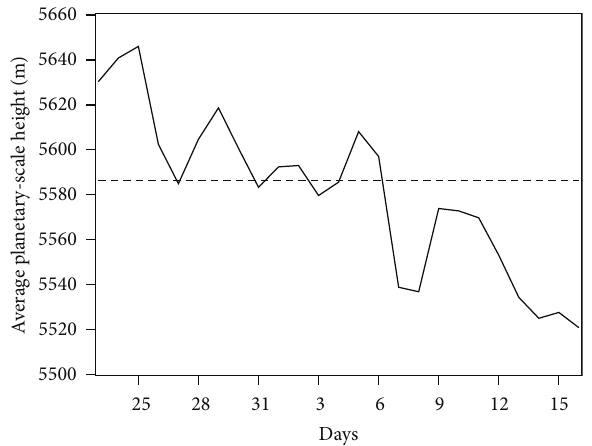
Figure 8: Planetary-scale 500 hPa geopotential heights (m) for January 23–February 16. The horizontal line represents monthly mean.